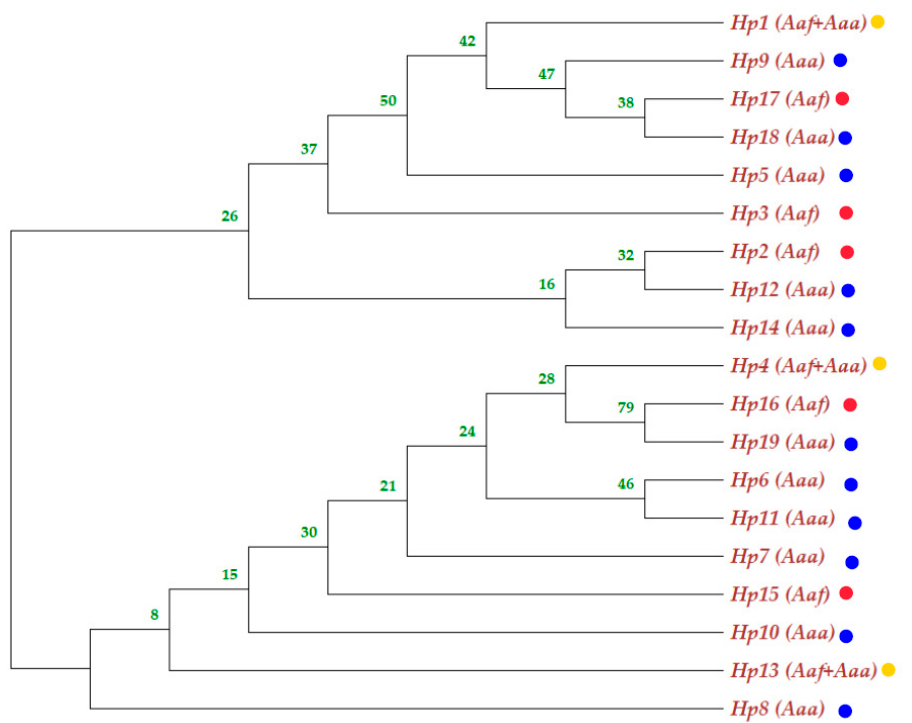
Figure 5. Neighbor-Joining phylogenetic tree involving nineteen haplotypes of ND4 mitochondrial gene sequences from eight Aedes aegypti subspecies populations in Sudan. The yellow dot haplotypes were shared between the subspecies; the blue dot indicates Aaa haplotype, while the red dot indicates Aaf haplotype.